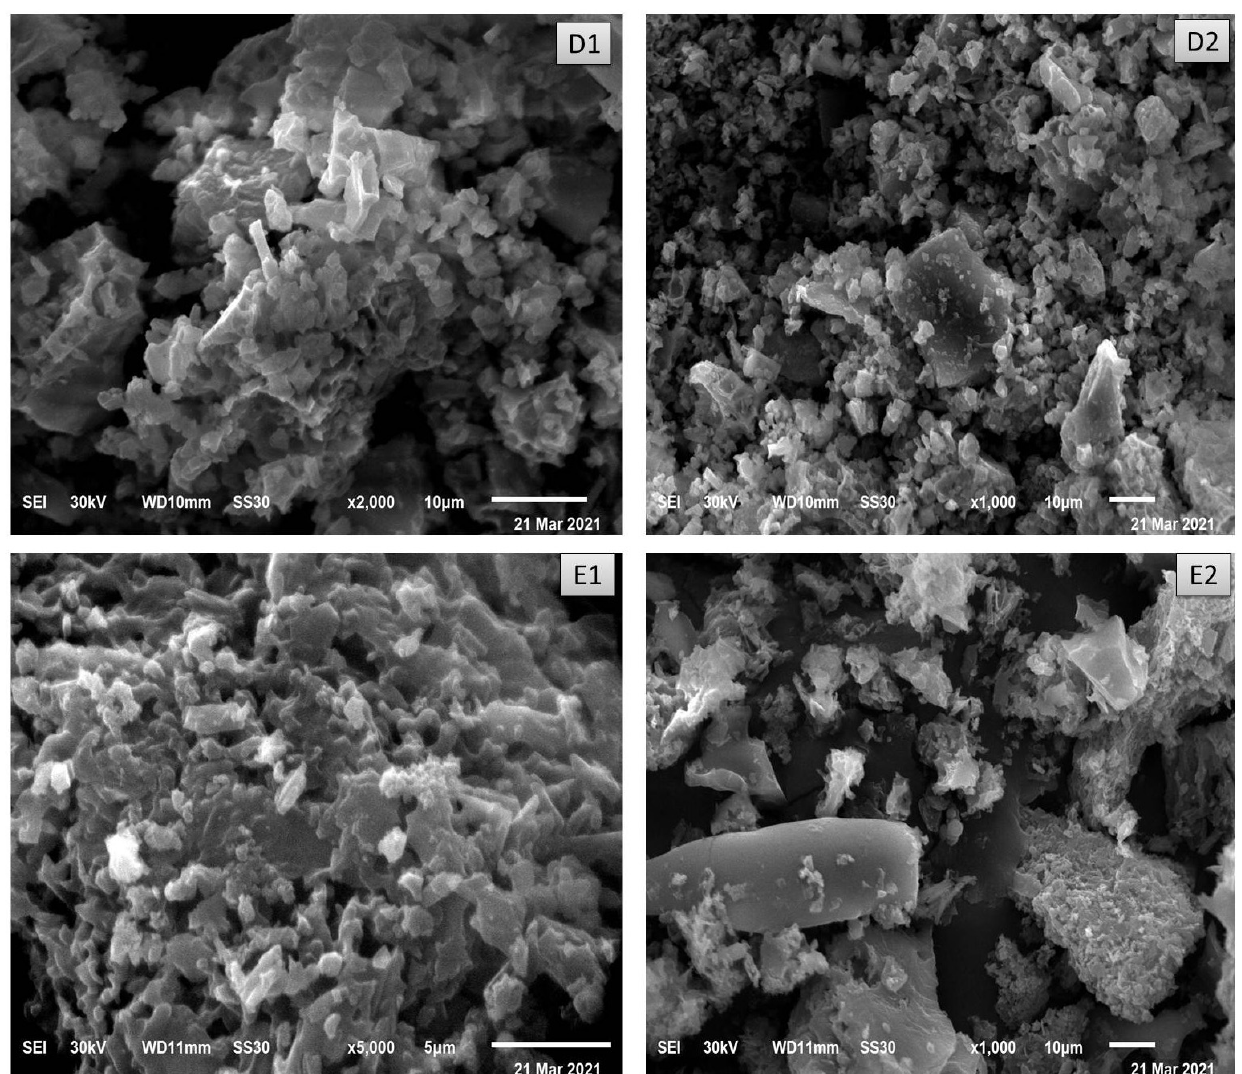
Figure 6. SEM ( A1 , A2 ) Mg, ( B1 , B2 ) Cu, ( C1 , C2 ) Fe, ( D1 , D2 ) Se and ( E1 , E2 ) Zn CFX complexes. Images of TEM for [Mg(CFX)(H 2 O) 2 ] · 4H 2 O, [Cu(CFX)(H 2 O) 2 ] · 3H 2 O, [Fe(CFX)(H 2 O) 2 ] · 5H 2 O, [Zn(CFX)(H 2 O) 2 ] · 4H 2 O and [Se(CFX)Cl 2 ] · 4H 2 O complexes are